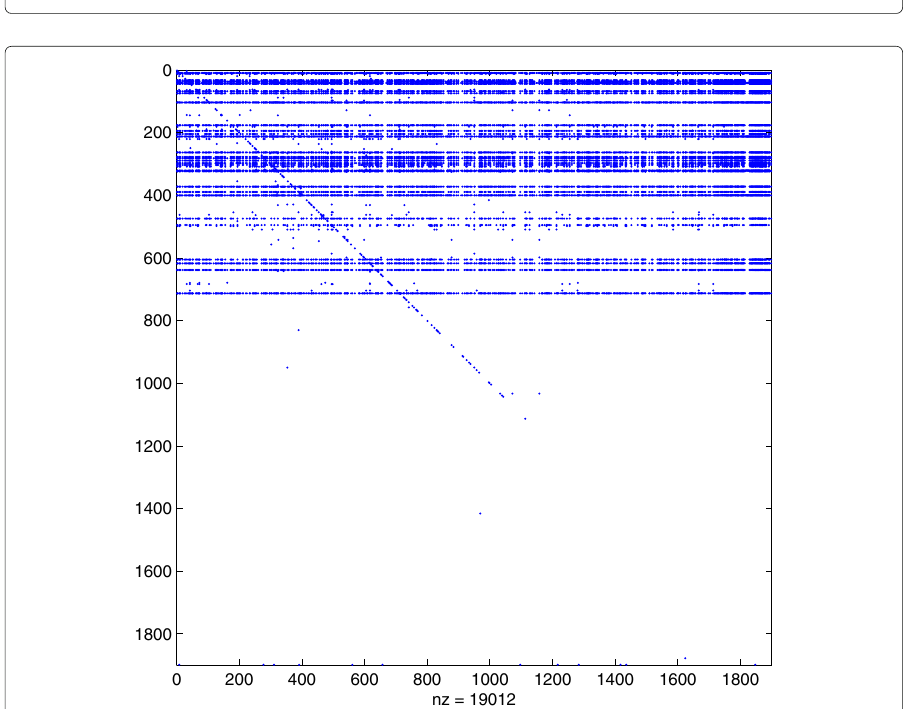
Fig. 12 Sparsity pattern. FBsoc: sparsity pattern of the final matrix (cid:12) Q [ M ] computed using (4) with α =